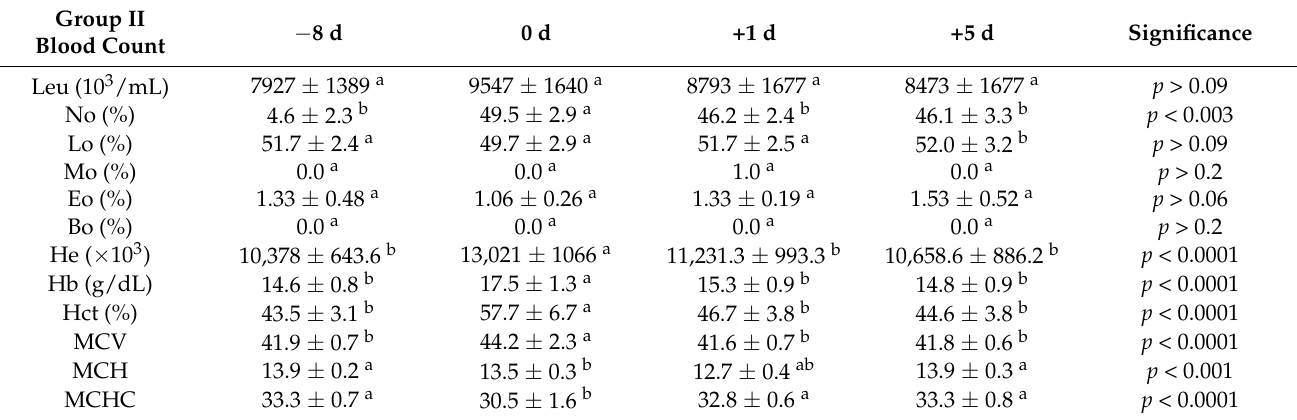
Table 8. Values represent the average and standard deviation of the blood count results of the horses analyzed in the study: counting the total number of leukocytes (Leu); the relative number (%) of neutrophils (No), eosinophils (Eo), monocytes (Mo), and basophils (Bo); the total number of erythrocytes (He); hemoglobin concentration (Hb); globular volume (Hct); mean corpuscular volume (MCV); mean corpuscular hemoglobin (MCH); and mean corpuscular hemoglobin concentration (MCHC) at different collection times defined as − 8 d, 0 d, +1 d, and +5 d. Statistical difference according to the Tukey–Kramer test—Beltsville,